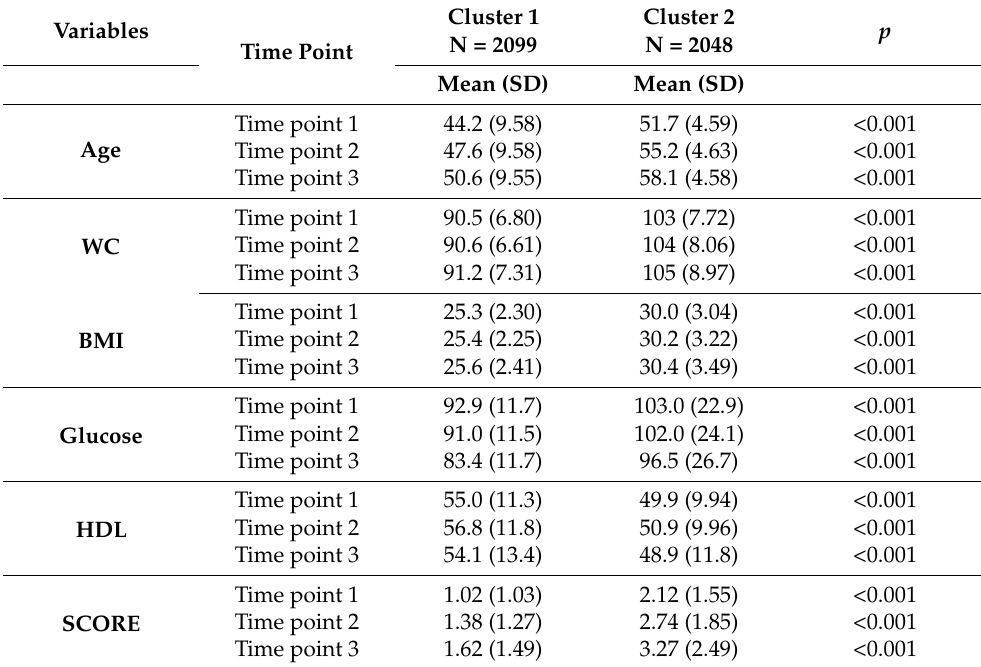
Table 3. Descriptive analysis of the variables included in the cluster analysis, stratified by cluster and time